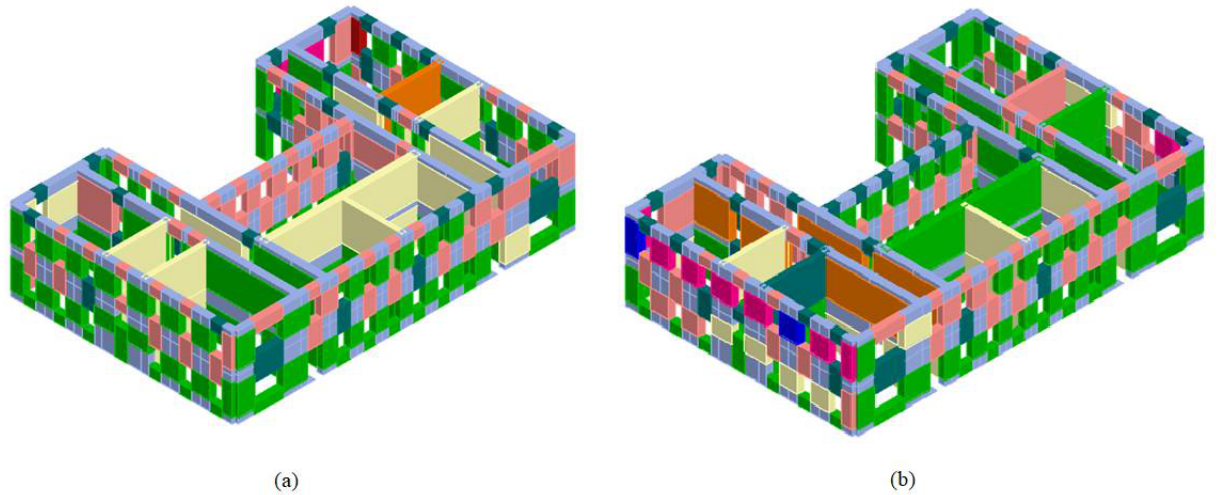
Figure 15. 3D view of damage for the most significant pushover analysis: ( a ) in x-direction; ( b ) in y-direction. Table 4. Values of vulnerability index α for the most significant analysis in the x and y direction.